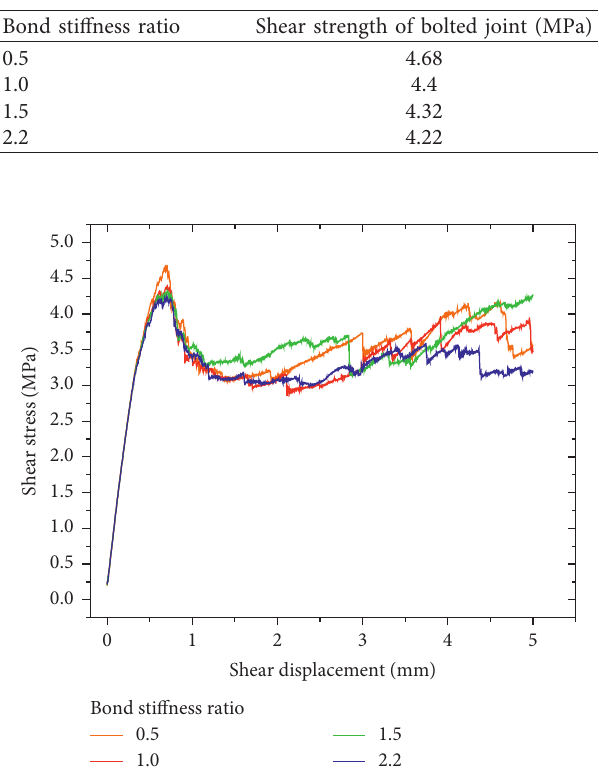
Figure 8: Shear stress deformation curves of bolted joints with different bonding stiffness ratios.